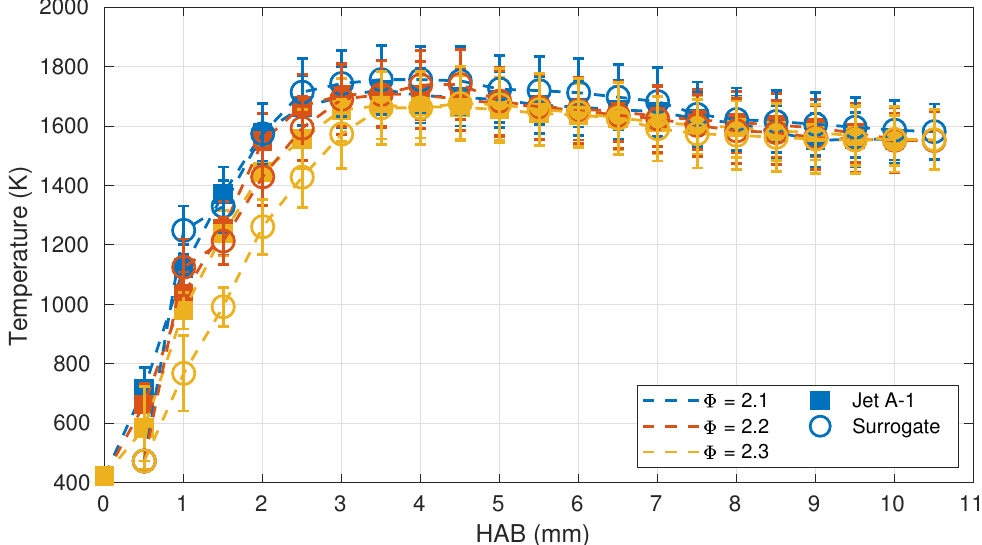
Figure 1. Temperature profiles measured with TDLAS at 6 cm/s inlet velocity for kerosene Jet A-1 and the